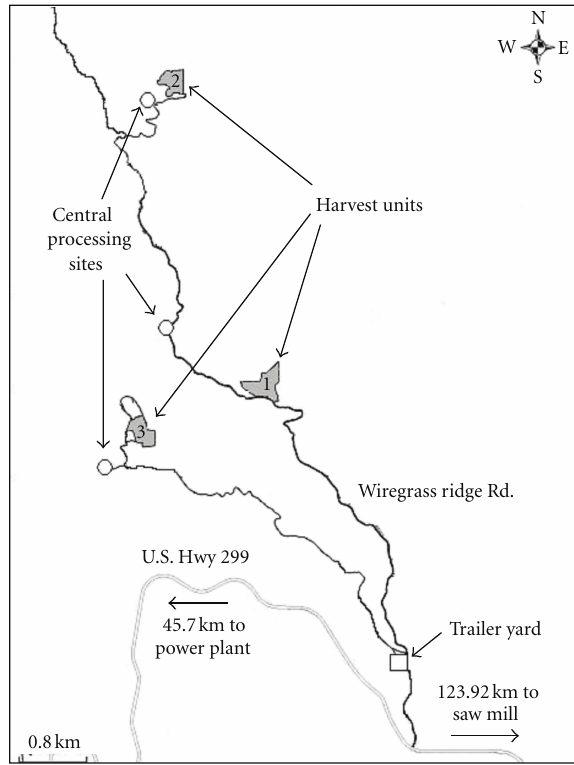
Figure 3: Operation layout map showing three harvest units with corresponding central processing sites. Whole trees and logs were hauled to the central processing sites to process and sort into biomass and